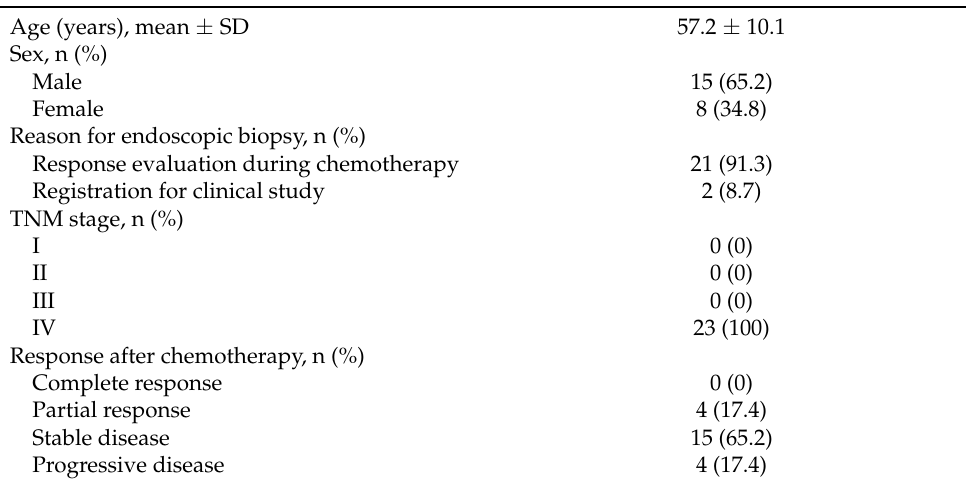
Table 1. Characteristics of the enrolled patients (n = 23).